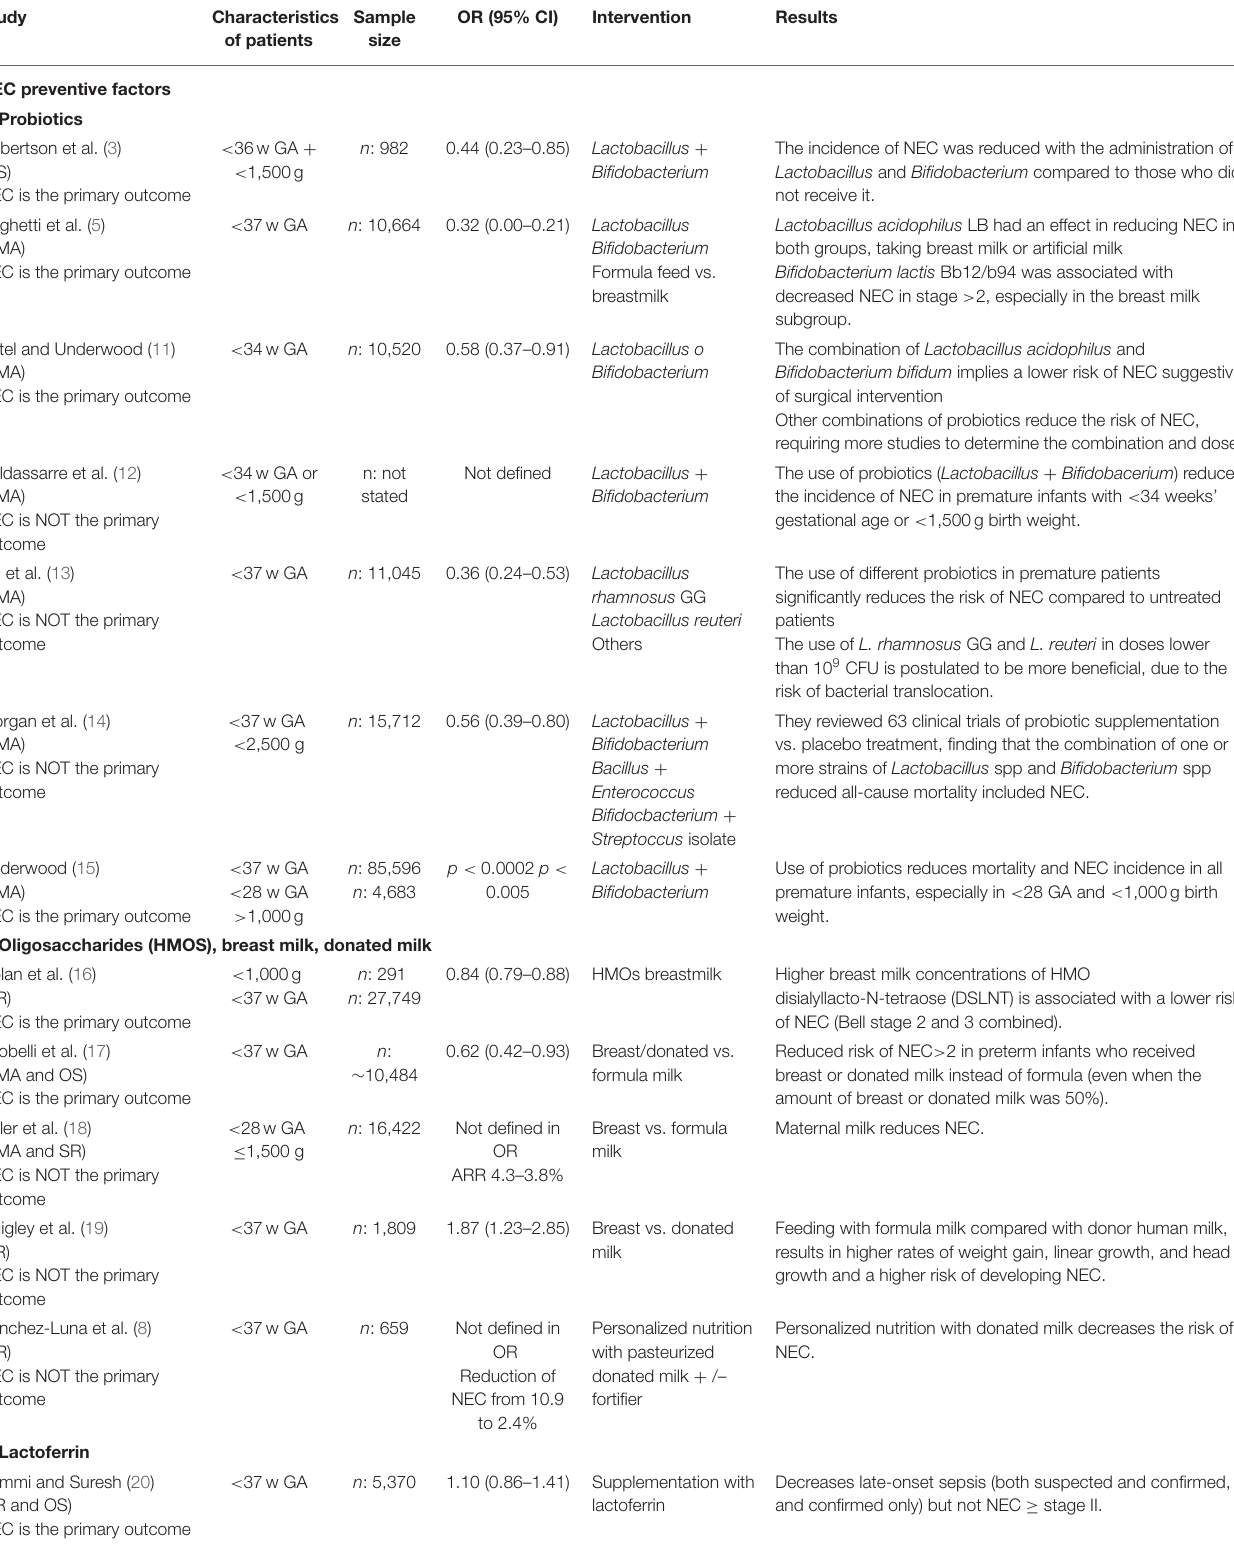
TABLE 1 | Characteristics of the studies included in the systematic review.